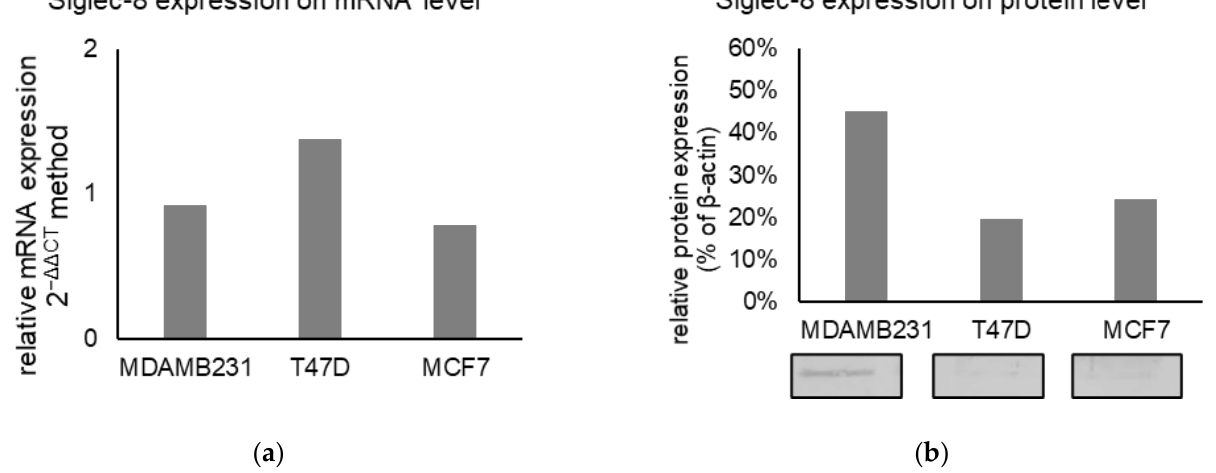
Figure 6. ( a ) Mean relative Siglec-8 expression on mRNA level (calculated with 2 − ∆∆ CT method) in different cell lines, Glyceraldehyde-3-Phosphate Dehydrogenase (GAPDH) was used as endogenous control for ∆ CT-values and the results are means of triplicates. ( b ) Mean relative Siglec-8 expression on protein level (as % of β Actin expression) in different lines. Beta-Actin was used as a loading control and for normalization and results are the mean of triplicates. Exemplary Western Blots are displayed below the